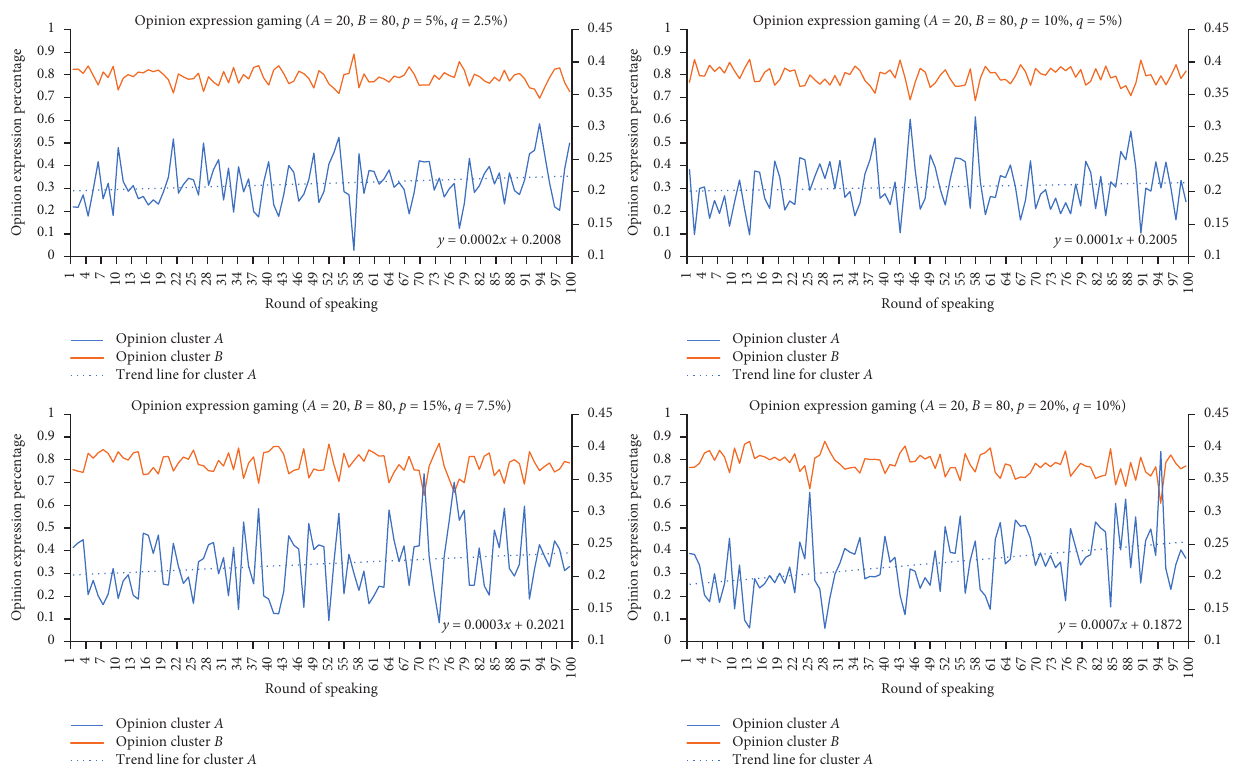
Figure 6: Minority/majority opinion expression. (For example, A � 20, B � 80). Note. Opinion expression percentage, with A (minority cluster) � blue thick line and B (majority cluster) � red thin line. Round of speaking represents time because each discussion allows 100 rounds of speaking. All the results were shown in the average score of 100 times’ simulation.